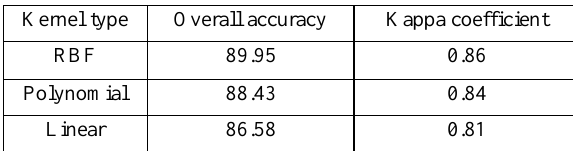
Table 1. Accuracy parameters of different kernel functions assessment